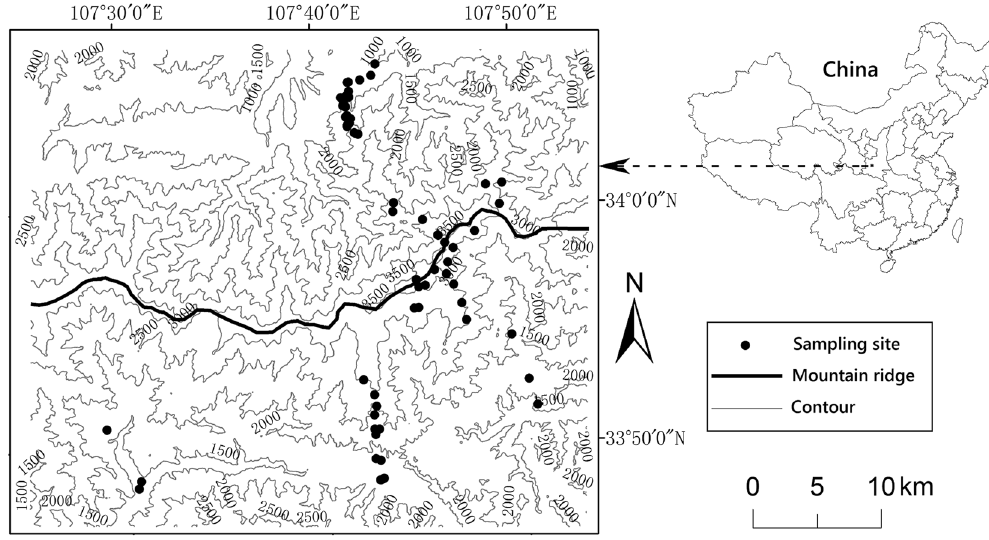
Figure 1. Map showing the study area and the sampling sites. The map was created with ArcGIS 10.1 (www.